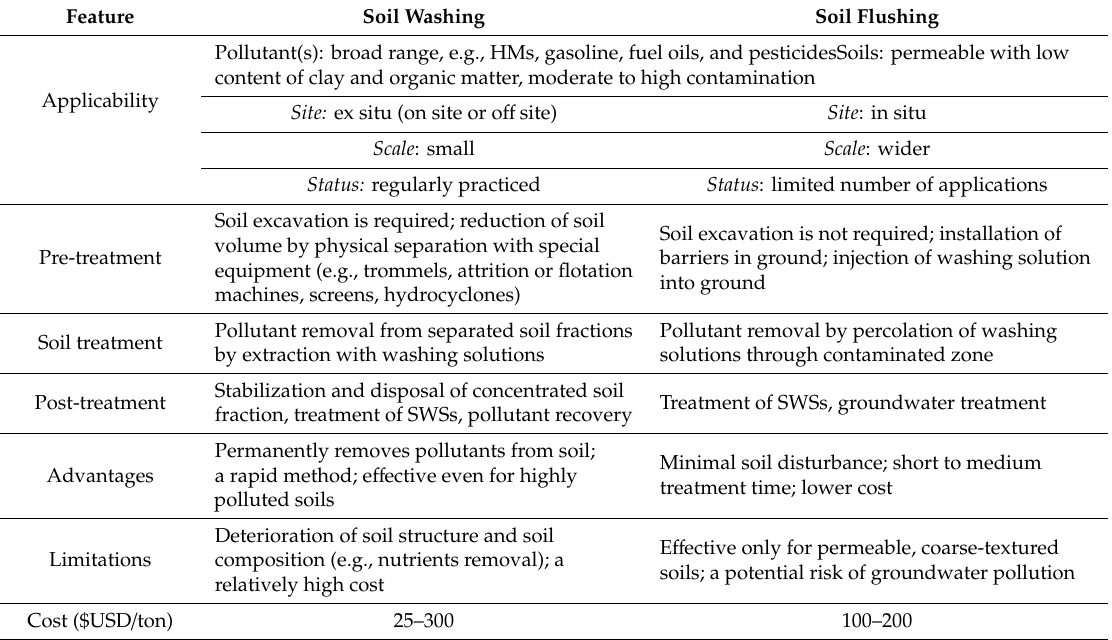
Table2. Summaryofsoilwashingandsoilflushingtechnologies[1,3,22,38]. USD—UnitedStatesdollars.